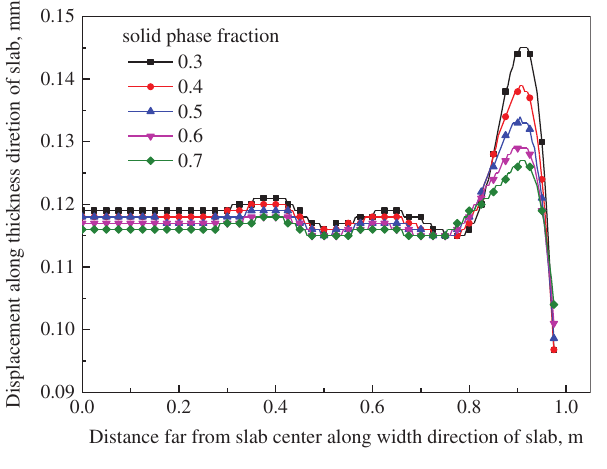
Figure 8: Relationship between displacement along thickness direction of slab and distance far from slab center.